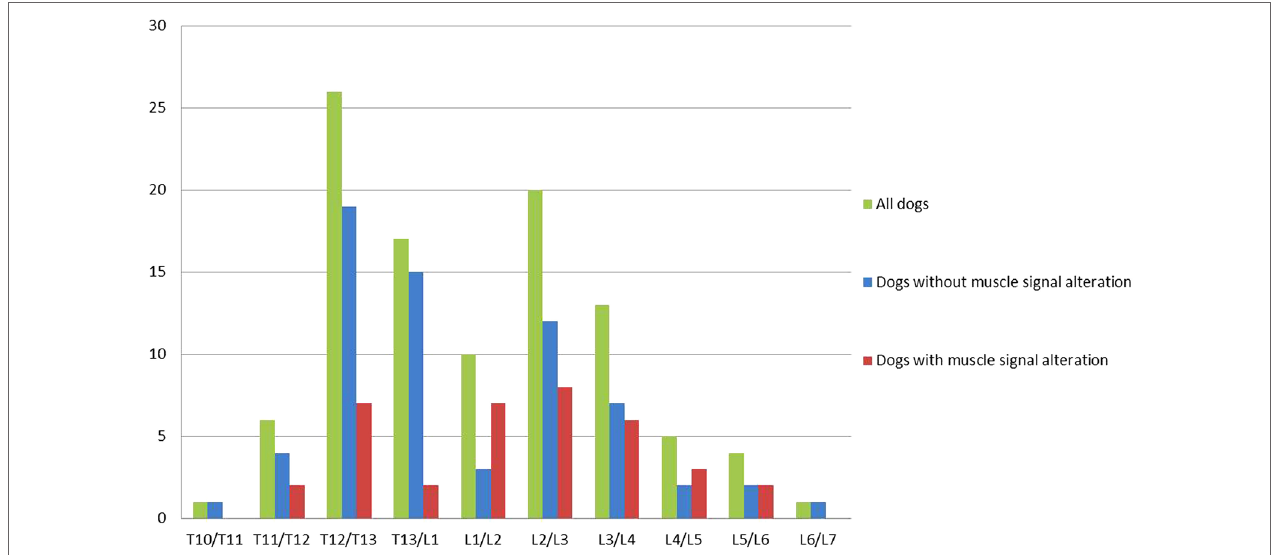
FigUre 3 | Graph illustrating the location of the intervertebral disk extrusion of all dogs, dogs without and with muscle signal alteration. Dogs with a disk extrusion caudal to L1 had a higher risk for muscle signal changes (OR = 2.8, P = 0.03) than dogs with a disk extrusion cranial to